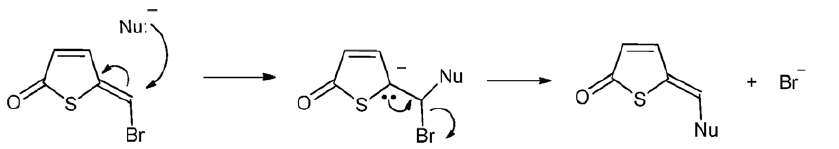
Figure 5. Proposed reaction mechanism of the thiophenones. Nu: nucleophile. Candidate nucleophiles are e.g. thiol groups of cysteine residues.